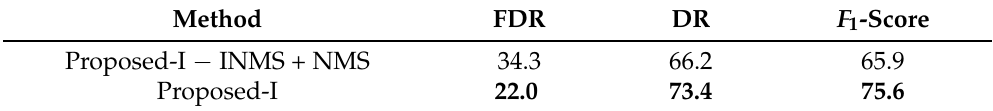
Table 4. The ablation experiments (%) on the testing set for INMS. CNN lw was taken as the backbone network; “ − ” and “+” denote the elimination and employment of a certain part, respectively.